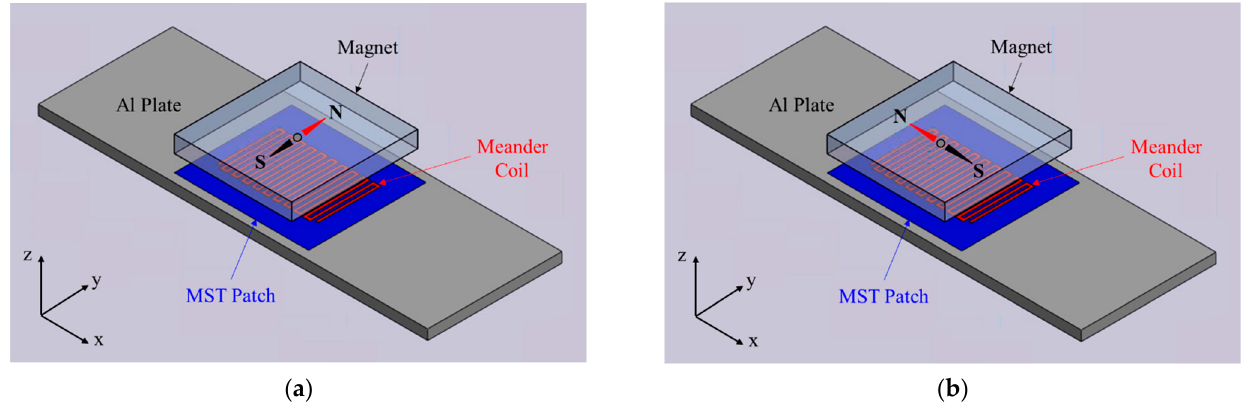
Figure 2. Magnetostrictive transducers for guided wave generation and reception in a plate: ( a ) SH wave MST; ( b ) Lamb wave MST.